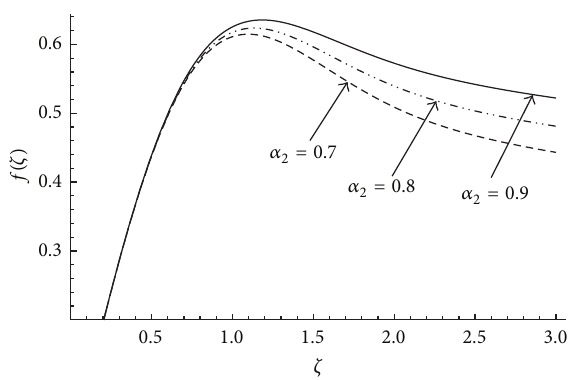
Figure 2: The effect of changing 𝛼 2 on the solution 𝑓(𝜁) at 𝛼 1 = 0.9 ,